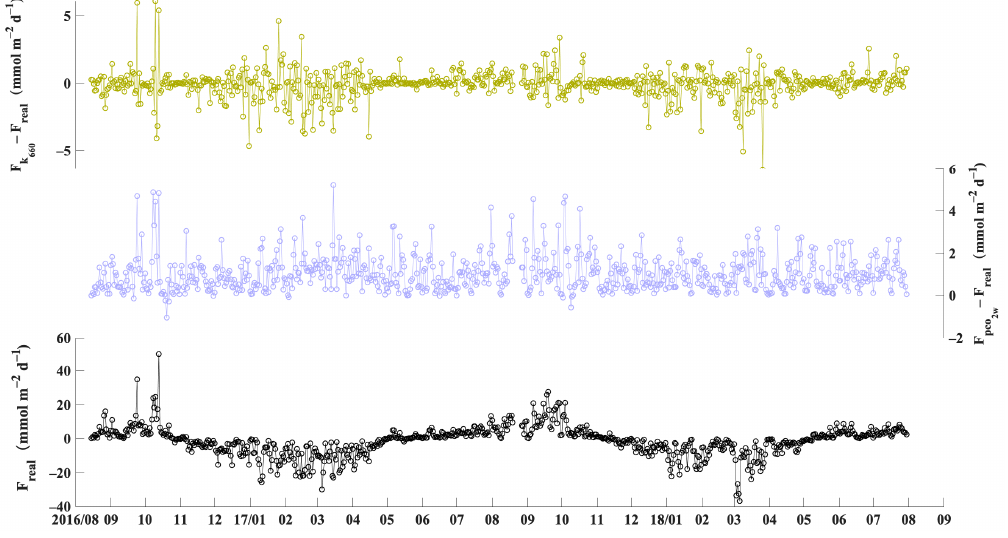
F F − and F F − ) and F real at HogReef Figure 7. Differences in experimental CO − F − F 2 fluxes ( F k 660 real and F pCO 2 w real ) and F real at HogReef 660 real k 2 real w pCO